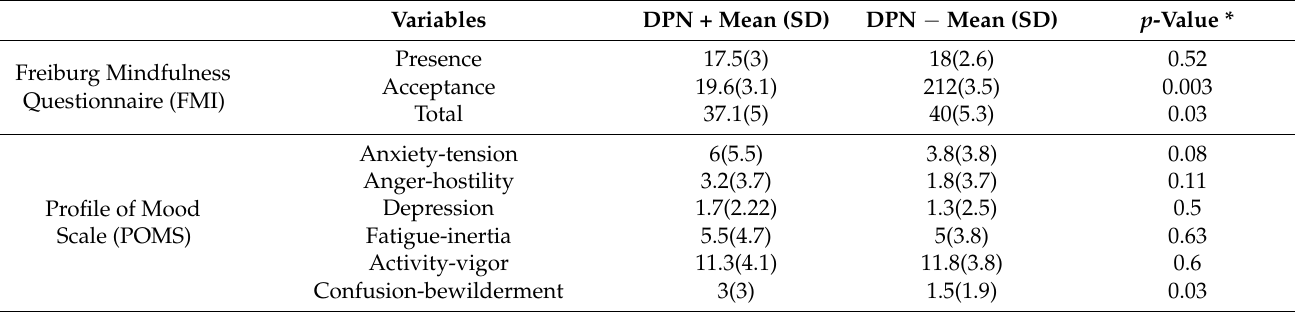
Table 4. Differences between PND + and PND − for the FMI and POMS key questionnaires at VI in the sample of 72 women.